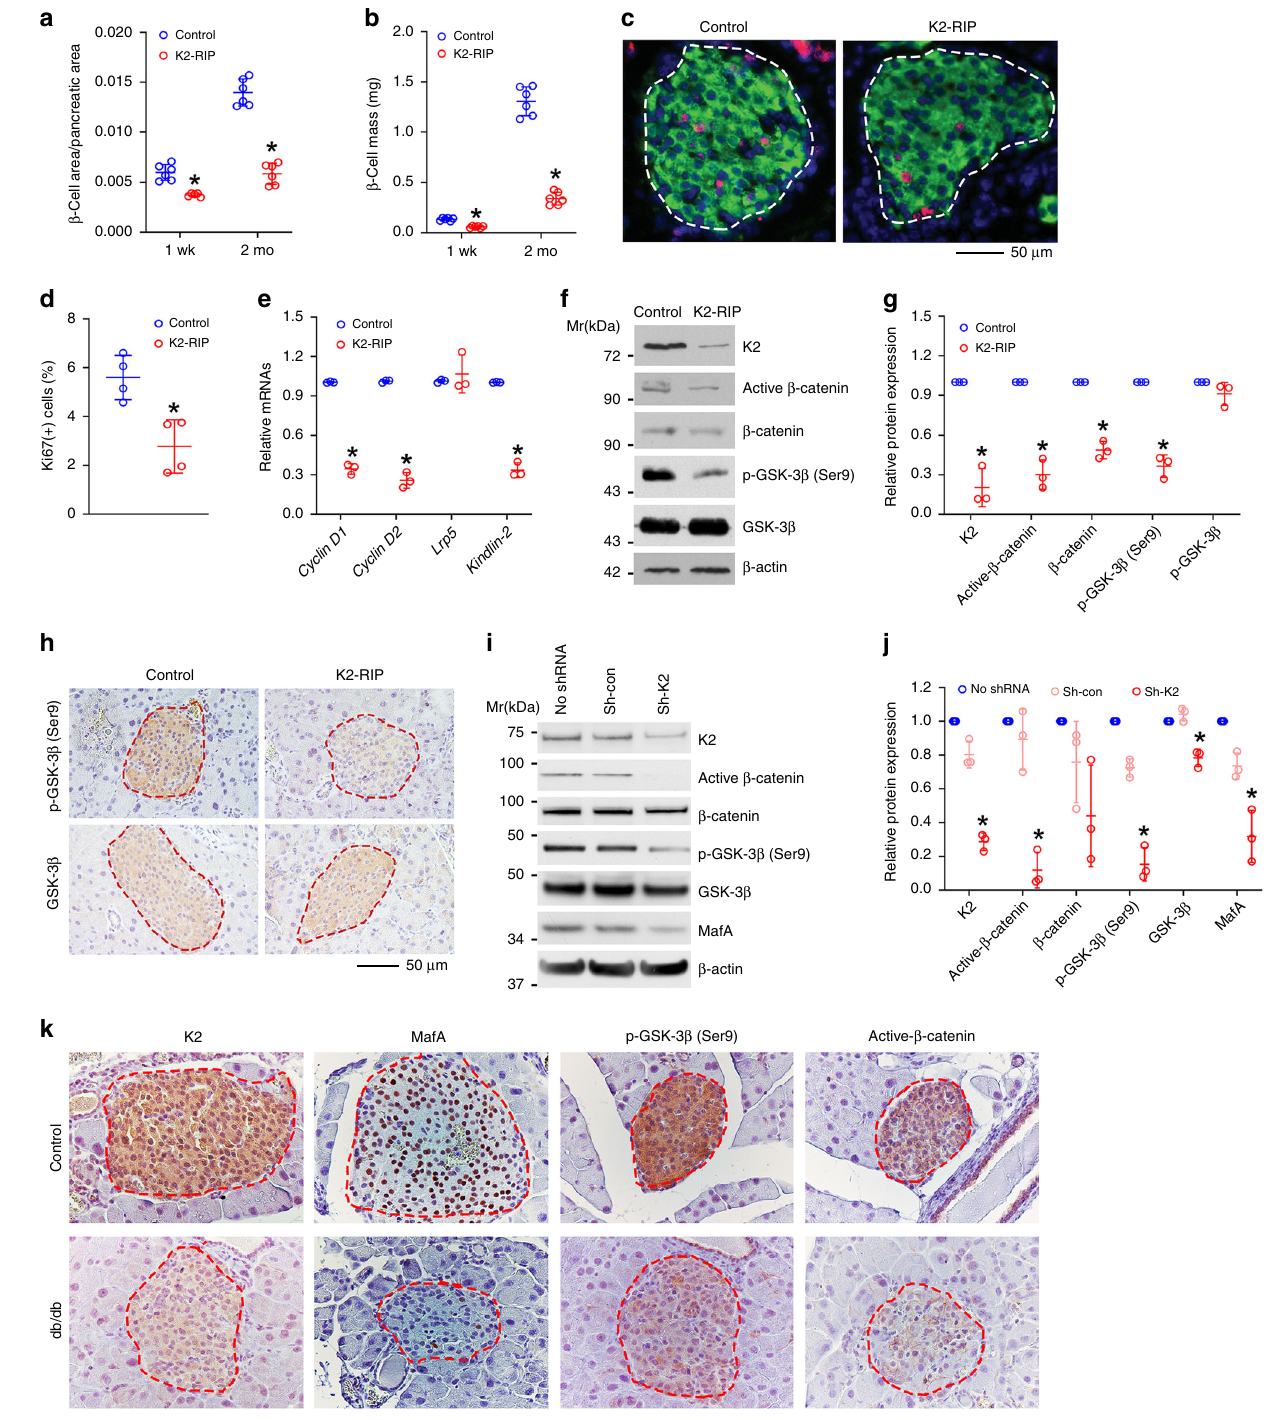
immunoprecipitate (Fig. 5f) and, vice versa, that Kindlin-2 protein was present in an anti-MafA immunoprecipitate (Fig. 5g). The interaction between the endogenous Kindlin-2 and MafA proteins was demonstrated by IP using extracts from rat pancreatic INS-1 cells (Fig. 5h, i). Results from the pull- down assays using puri fi ed GST-Kindlin-2 and glutathione S- transferase (GST)-MafA fusion proteins revealed a direct phy- sical interaction between Kindlin-2 and MafA proteins (Fig. 5j, k). To identify domain(s) within the Kindlin-2